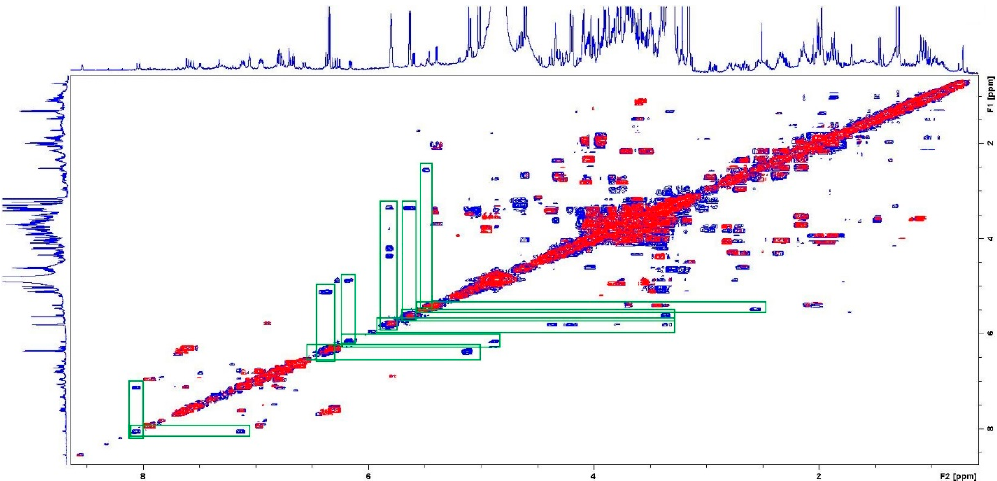
Figure 3. Overlaid 1 H– 1 H–COSY spectra of both samples: infusion of S. cypria (red colour) and infusion of S. perfoliata subsp. perfoliata (blue colour). The different correlation peaks were signed with green colour boxes.